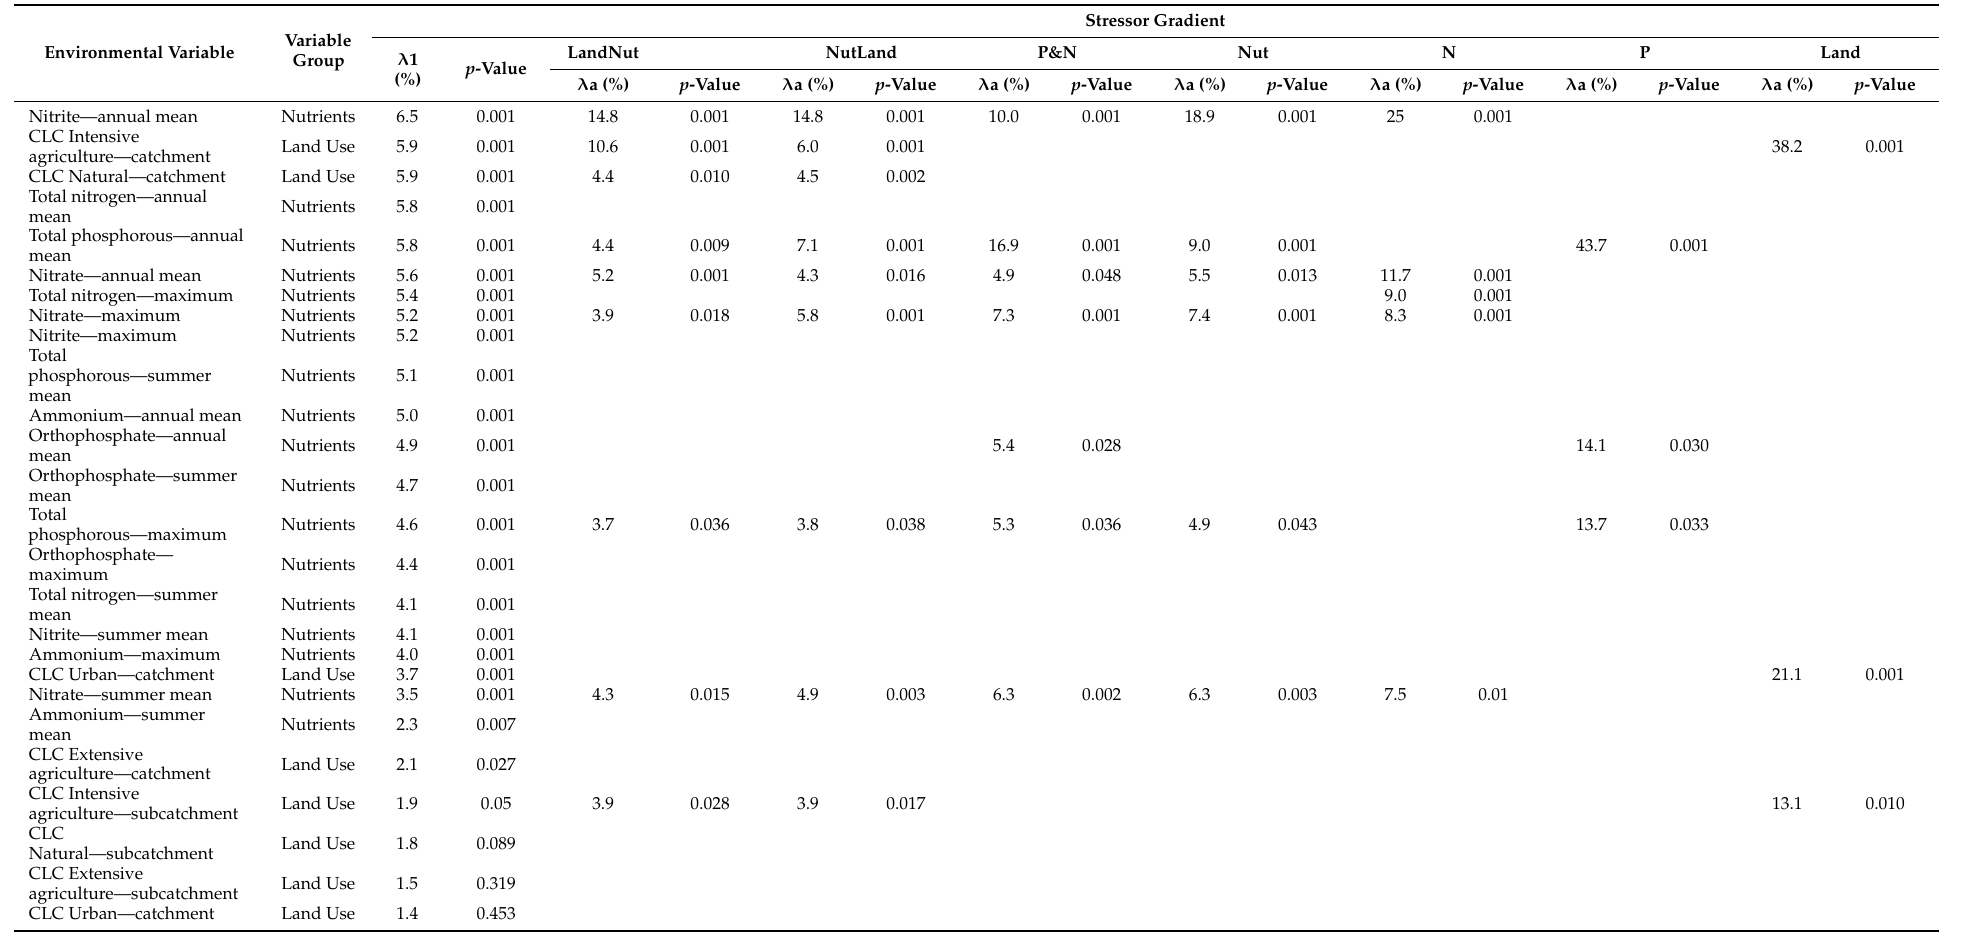
Table 6. Percentage of the phytobenthic assemblage variance explained by each environmental variable before forward selection ( λ 1) and after forward selection ( λ a) within each stressor gradient group. Values of λ a are given only for variables with statistically significant explanatory variables ( p < 0.05). LandNut—land use and nutrients, NutLand—nutrients and land